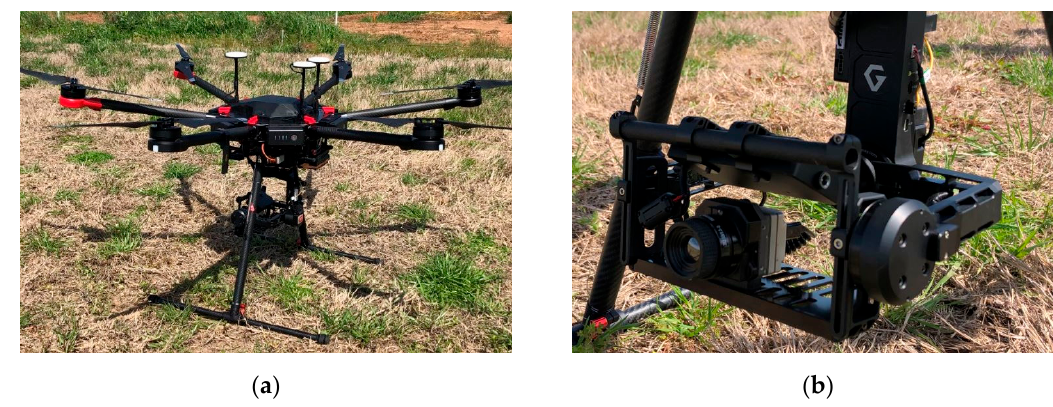
Figure 1. Unmanned aerial vehicle, ( a ) DJI Matrice 600 Pro and ( b ) ICI thermal camera.